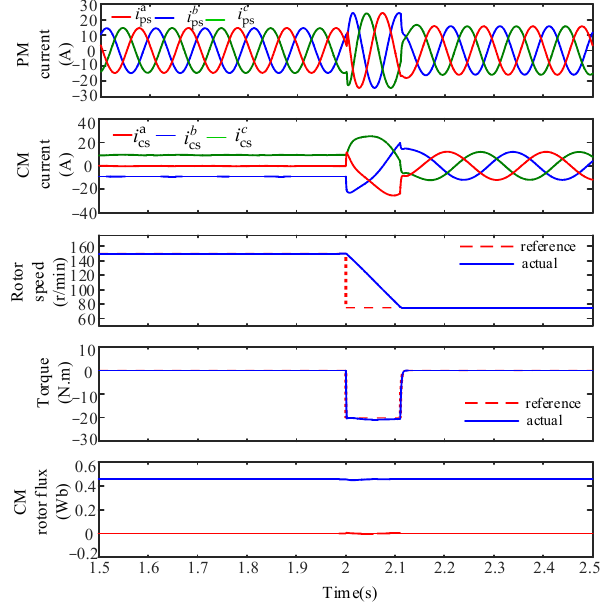
output and power supply frequency is 5 Hz). The CM rotor flux and the rotor speed are controlled to track the reference value accurately.